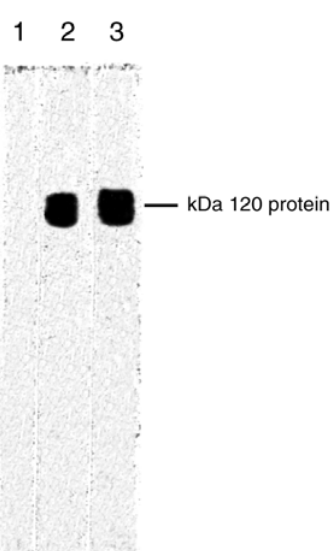
Figure 1. Immunoblot analysis of r-gp120 produced by vEP-COS-7 cells and insect cell/baculovirus system. Virus-free culture supernatant of vEP-infected COS-7 cells was run through lentil lectin- conjugated agarose bead column. Bound glycoprotein was eluted with 10% mannoside in PBS/Tris buffer, purified by DEAE 52 ion exchange chromatography, dialyzed and concentrated. Five µg of the concentrate was resolved by the SDS-PAGE and analyzed by Western blotting, using anti-gp120 polyclonal antibody. Lane 1: preparation from control cell supernatant; lane 2: preparation from vEP- infected COS cells; lane 3: purified insect cell/baculovirus system-expressed r-gp120.